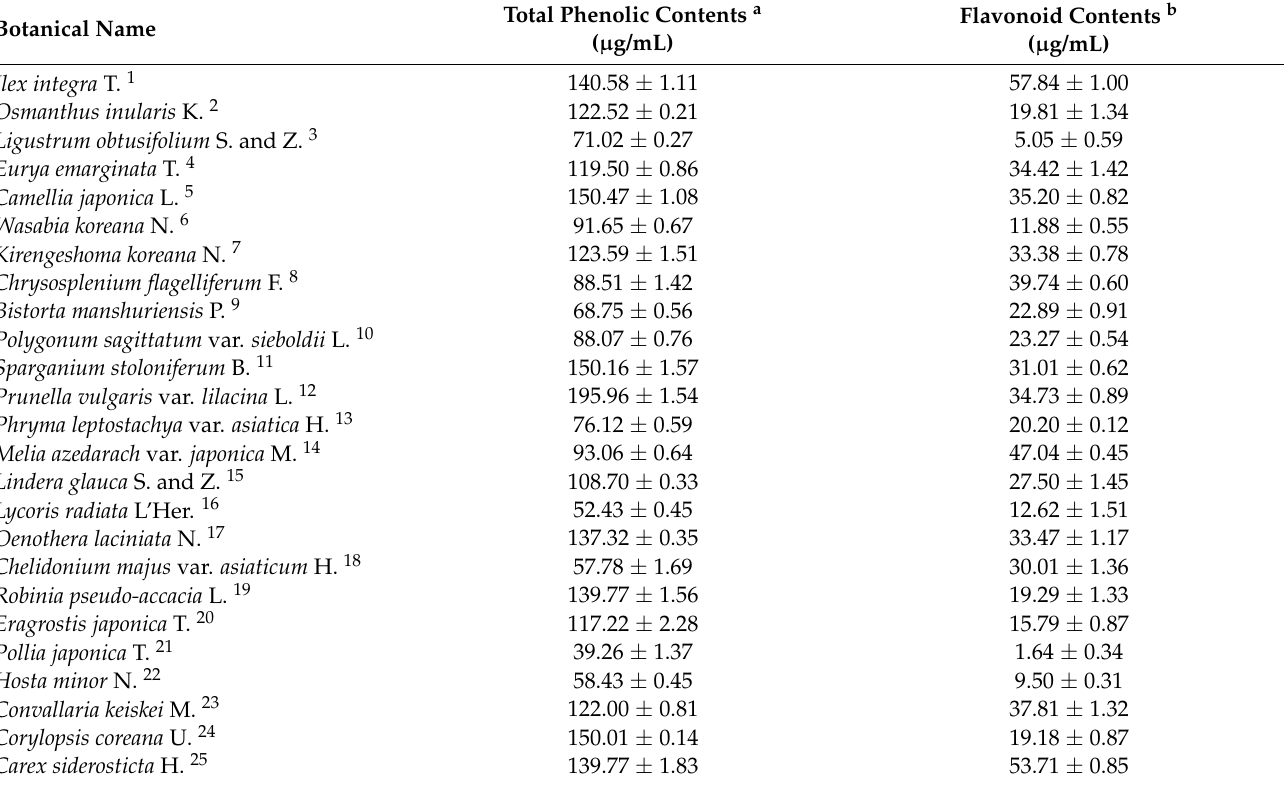
Table 1. Total phenolic and flavonoid contents in plant extracts evaluated in this